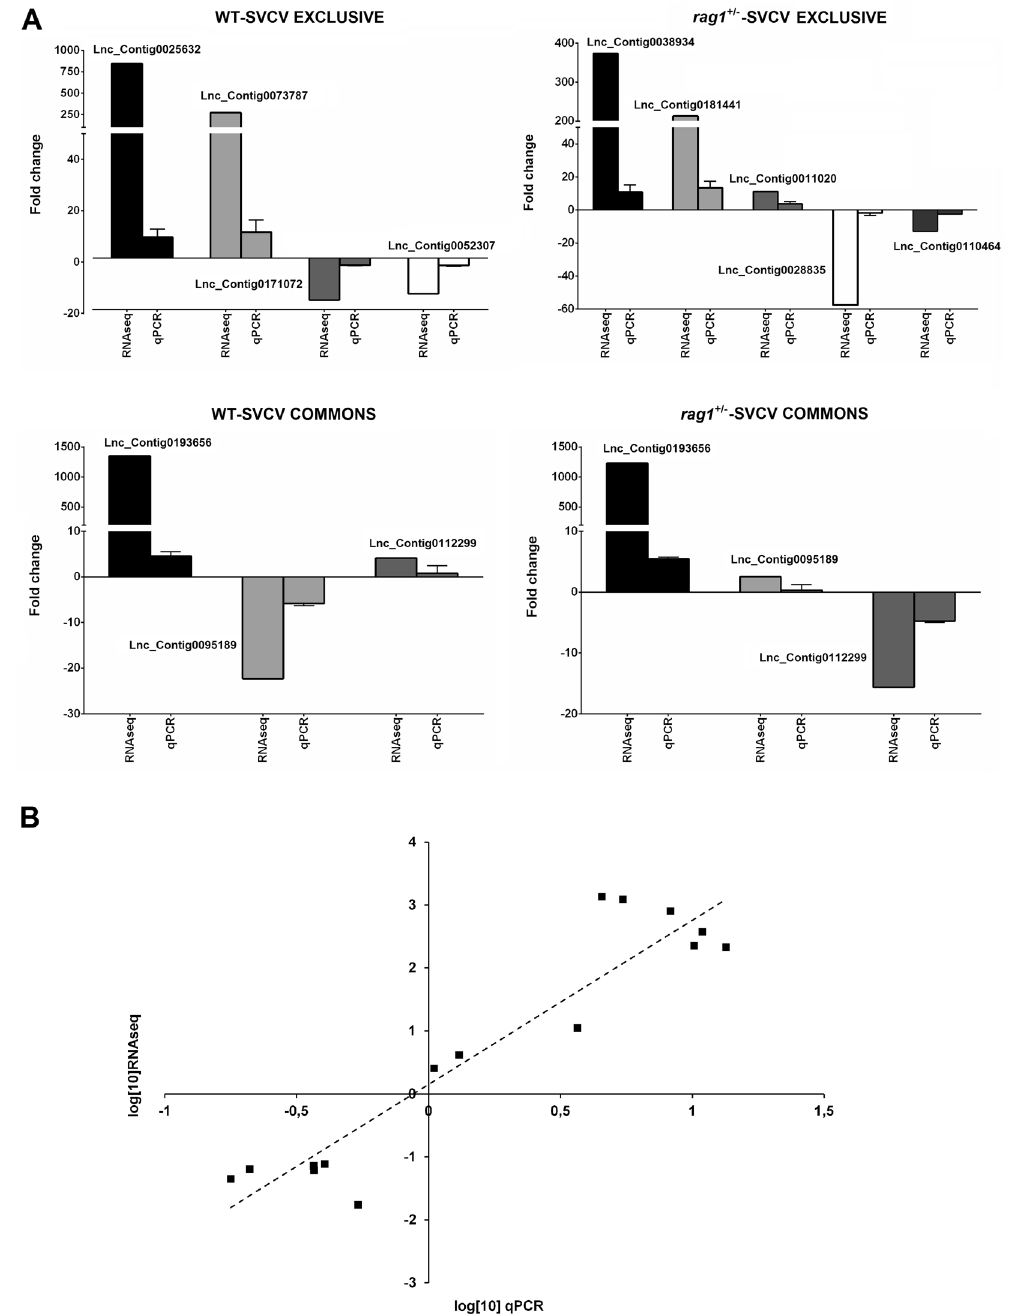
Figure 9. qPCR validation of the lncRNA expression. ( A ) qPCR and in silico fold-change values of twelve lncRNAs modulated after SVCV challenge in WT and/or rag1 + / − zebrafish transcriptomes, ( B ) Correlation between the qPCR and RNA-Seq fold-change values evaluated using Pearson’s correlation coefficient (r =